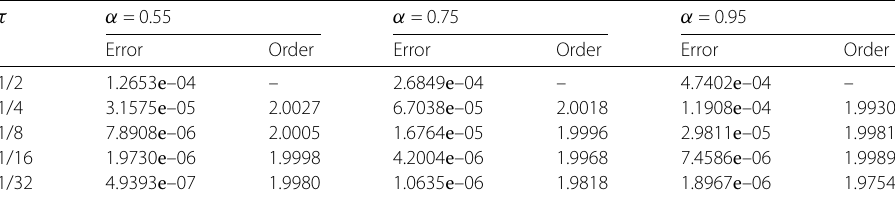
Figure 1 Numerical errors versus polynomial degree N for Example 1 with different